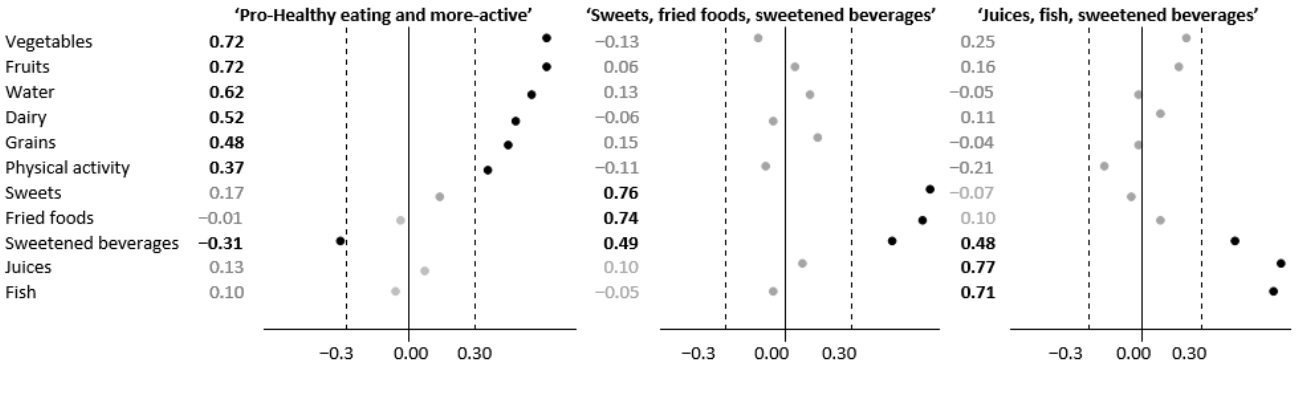
Figure 2. The values of factor loadings for selected food groups and physical activity in PCA-derived dietary–physical activity patterns (D-PAPs) ( n = 361).